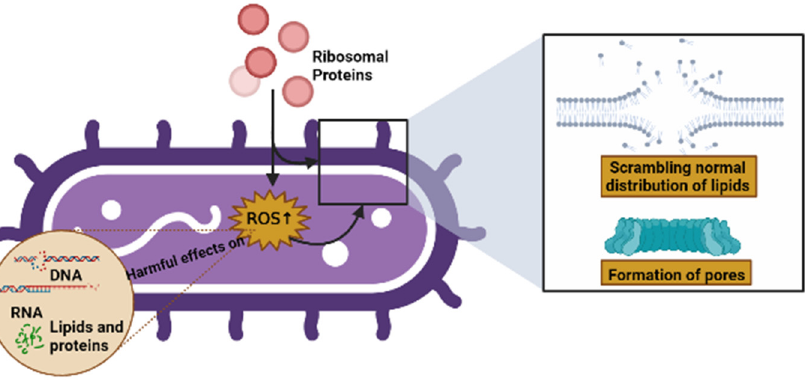
Figure 5. Possible causes of cell death caused by RPs (created by Biorender.com) (accessed on 17 June 2022).